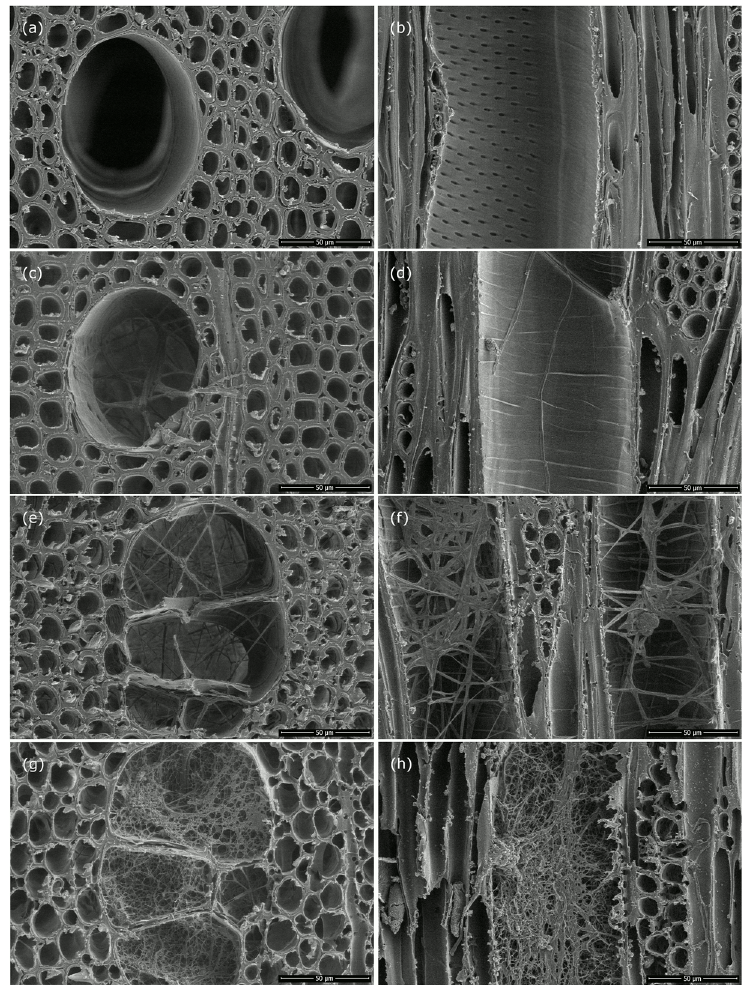
Figure 8. Scanning electron microscopy images of cross and tangential sections of ( a , b )